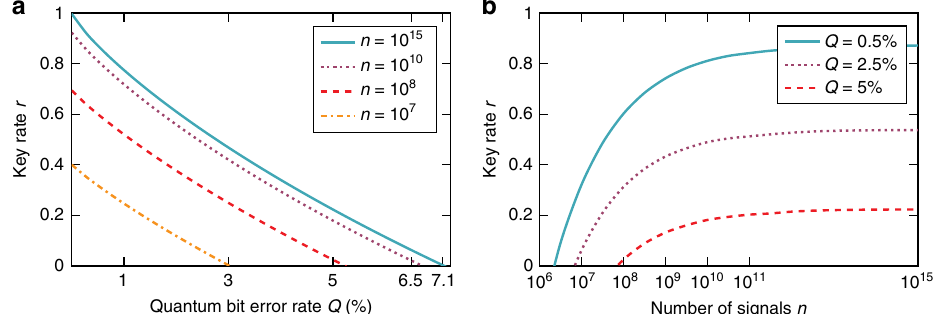
Fig. 5 Key rate in a DIQKD protocol. The plots show the key rate r as a function of a the quantum bit error rate Q and b the number of signals n . The completeness error, i.e., the probability that the protocol aborts when using an honest implementation of the device, e.g., due to statistical fl uctuations, was chosen to be ε c ¼ 10 (cid:2) 2 . The soundness error, which quanti fi es the maximum tolerated deviation of the actual protocol from a hypothetical one where a QKD perfectly random and completely secret key is produced for Alice and Bob, is taken to be ε s ¼ 10 (cid:2) 5 . Both of these values are considered to be realistic QKD and relevant for actual applications. The rates are calculated using Eq. (35) which is derived in the Methods